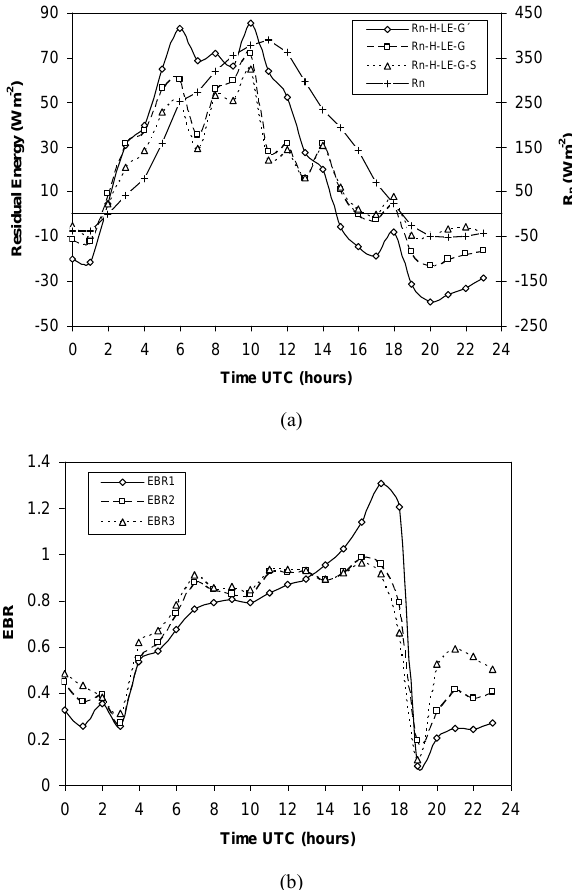
Fig. 2. Average diurnal variation of: (a) the residual energy in prin- cipal axis and net radiation in secondary axis, (b) the energy balance